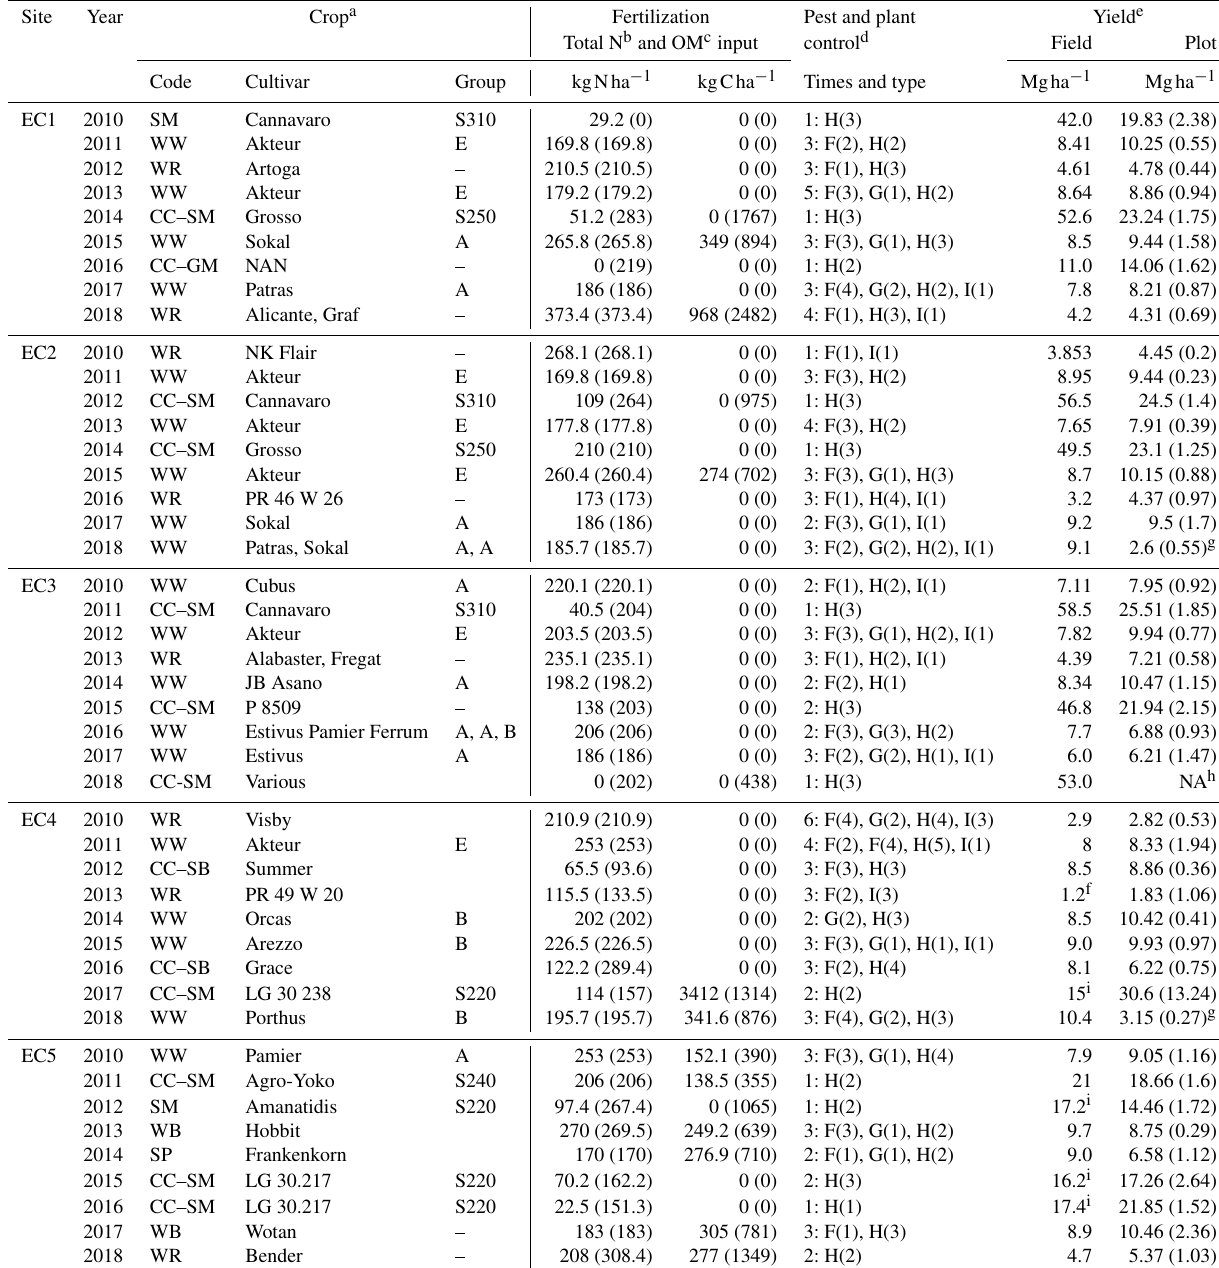
Table 3. Summary of field management and nitrogen and organic matter input.